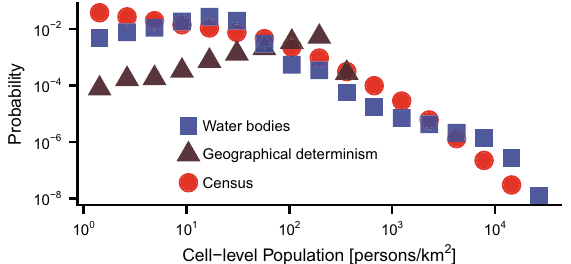
Figure 4. Population density distributions on a 6 km grid showing a typical Zipf’s Law relationship for the census data (red), and the LTP model (blue), which shows a comparably broad distribution. In contrast, a counterfactual ‘Geographical Determinism’ scenario (brown), with the same landscape conditions as ‘Water Bodies’, but lacking the reinforcement dynamics of the model, does not fit the census population